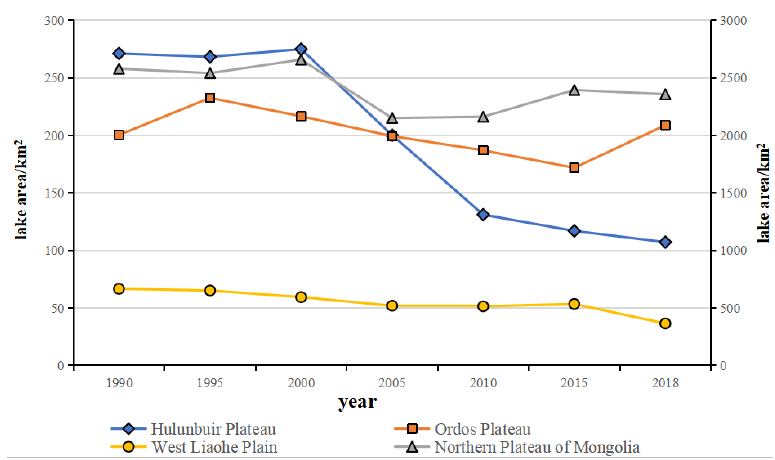
Figure 9. Changes in the lake area within 10 km of mining zones throughout the different geomor- phological units.